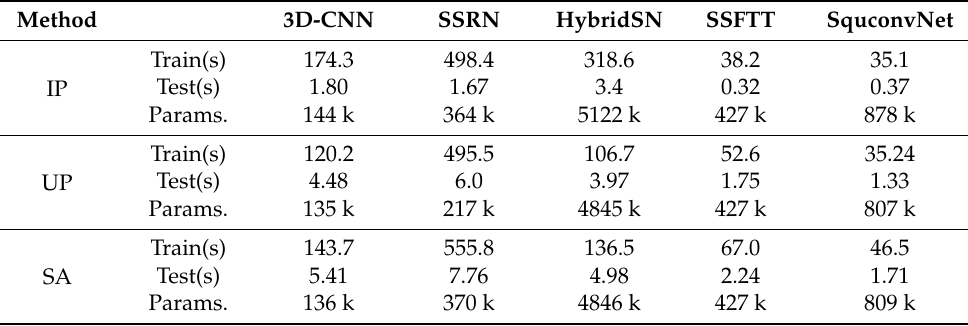
Table 9. Training and Test time of different methods on three